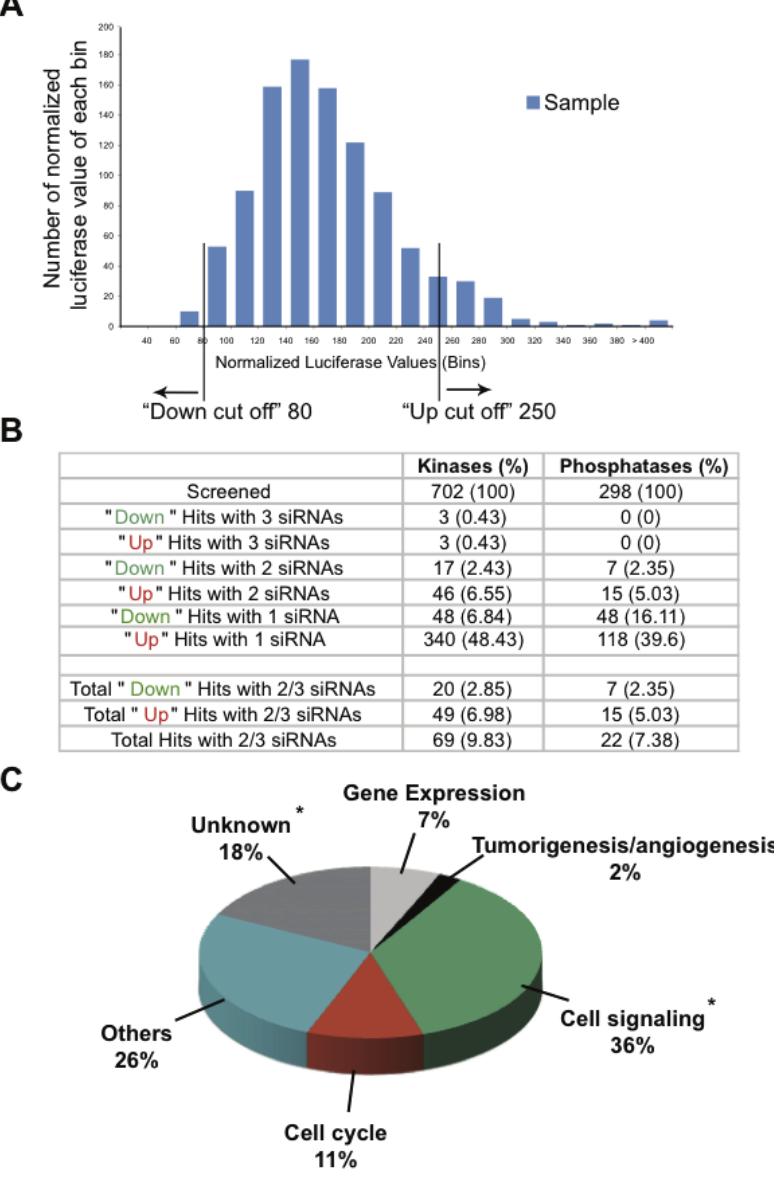
Figure 2. Identification of kinases and phosphatases modulating VEGF IRES activity. (a) Frequency distribution of the normalized median values of all samples (kinases and phosphatases). Numbers of normalized median values in each bin are shown on the y-axis, bins are shown on the x- axis. The cut-off values for up and down hits are indicated. (b) 702 kinases and 298 phosphatases were screened with three different siRNA sequences in three independent reactions, each performed in triplicates. Among them 69 kinases and 22 phosphatases had a similar effect on VEGF IRES activity when silenced with at least 2 different siRNA sequences in independent reactions. These 91 genes have been considered for further validation in secondary screening experiments. (c) Schematic classification of the 91 genes selected for validation studies according to their described function in GO annotation. * Two of the specific hits belong to the ‘‘Unknown’’ group and one to the ‘‘Cell signaling’’ group.